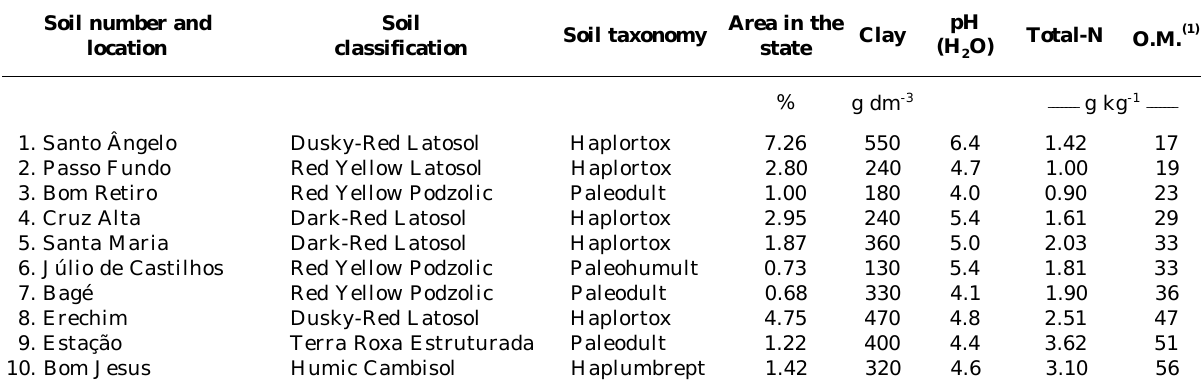
(1) Organic matter.